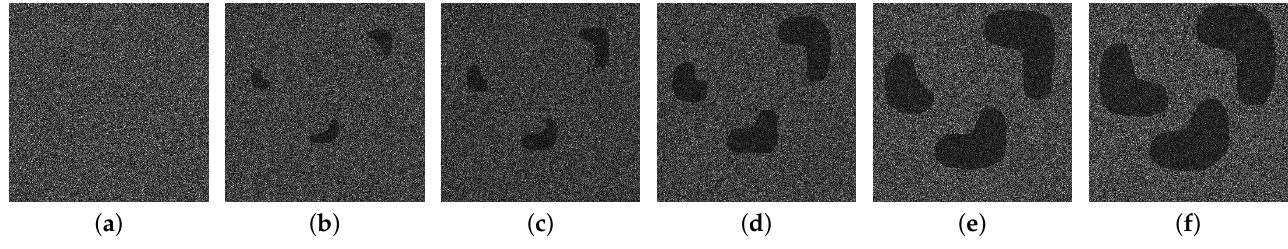
Figure 13. Simulated bi-temporal SAR image pairs. ( a ) Before image. ( b ) After Image #1 (2.5%). ( c ) After Image #2 (4.5%). ( d ) After Image #3 (11.6%). ( e ) After Image #4 (22.2%). ( f ) After Image #5